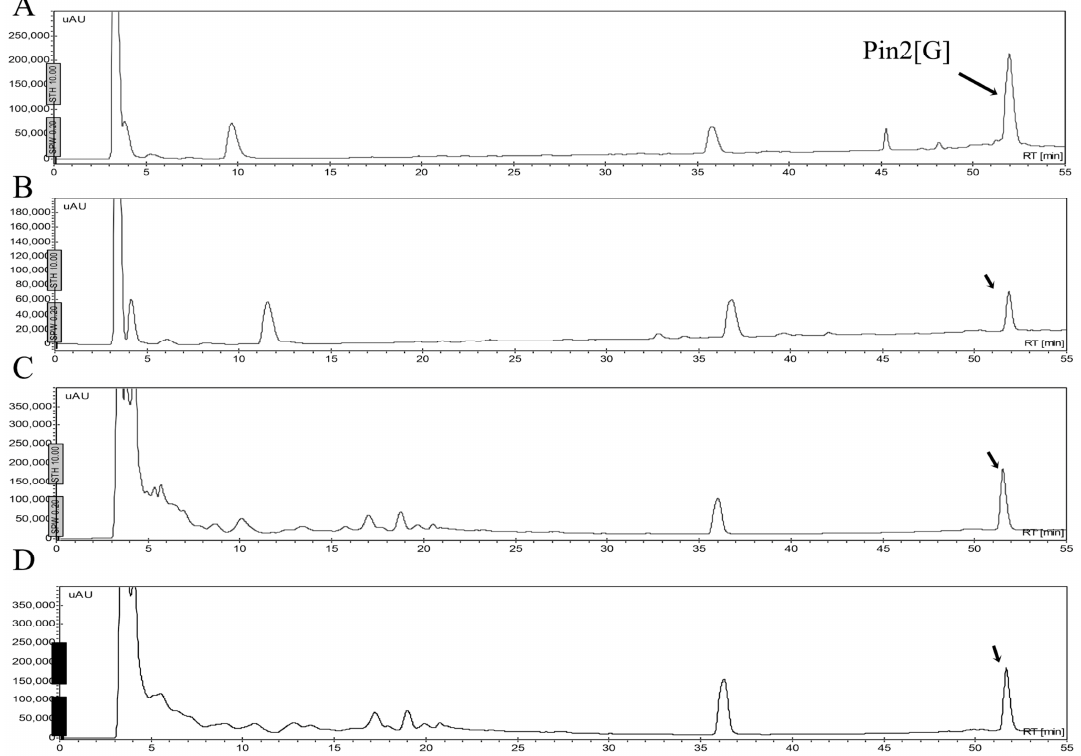
Figure 7. Stability of Pin2[G] in human blood plasma and bacterial supernatants. The peptide was either diluted in human blood or bacterial supernatants, incubated at 37 °C for 12 h and then extracted.